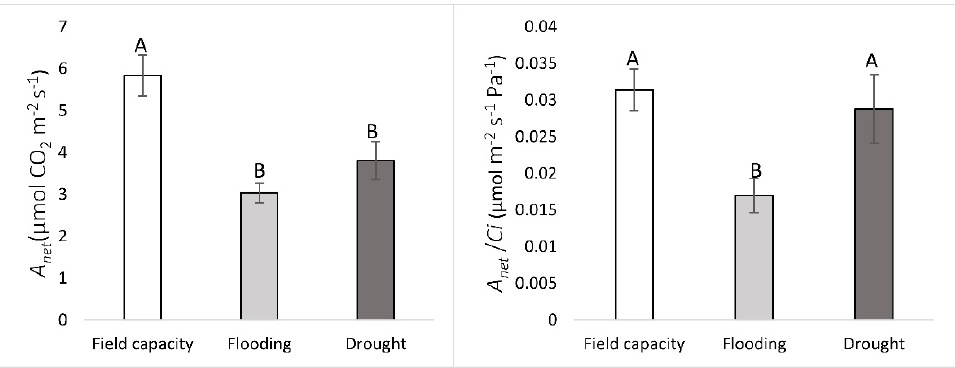
Figure 4. Carbon assimilation rate ( A net ) and Rubisco carboxylation efficiency ( A net /Ci ) in Annona crassiflora plants kept under Field capacity ( − 0.01 MPa), Flooding and Drought ( − 1.5 MPa) conditions at 5, 10 and 18 days after the application of treatments, respectively, and 168, 173 and 178 days after transplanting. Capital letters indicate significant differences among treatments ( p < 0.05).